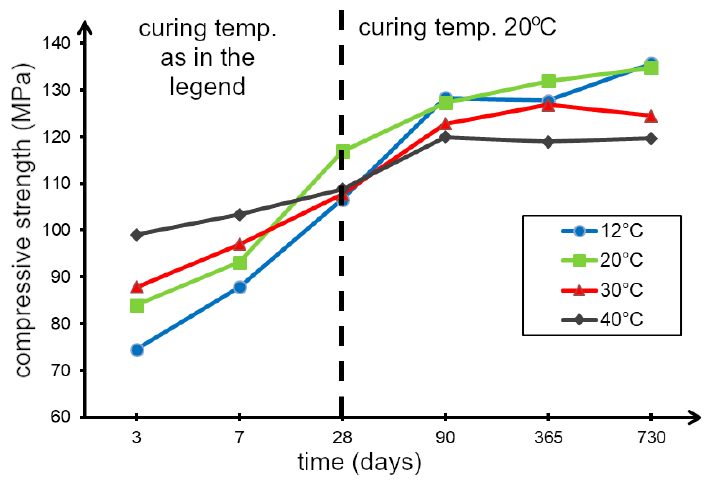
Figure 8. Results of compressive strength tests of concrete cured at 12 ◦ C, 20 ◦ C, 30 ◦ C and 40 ◦ C.